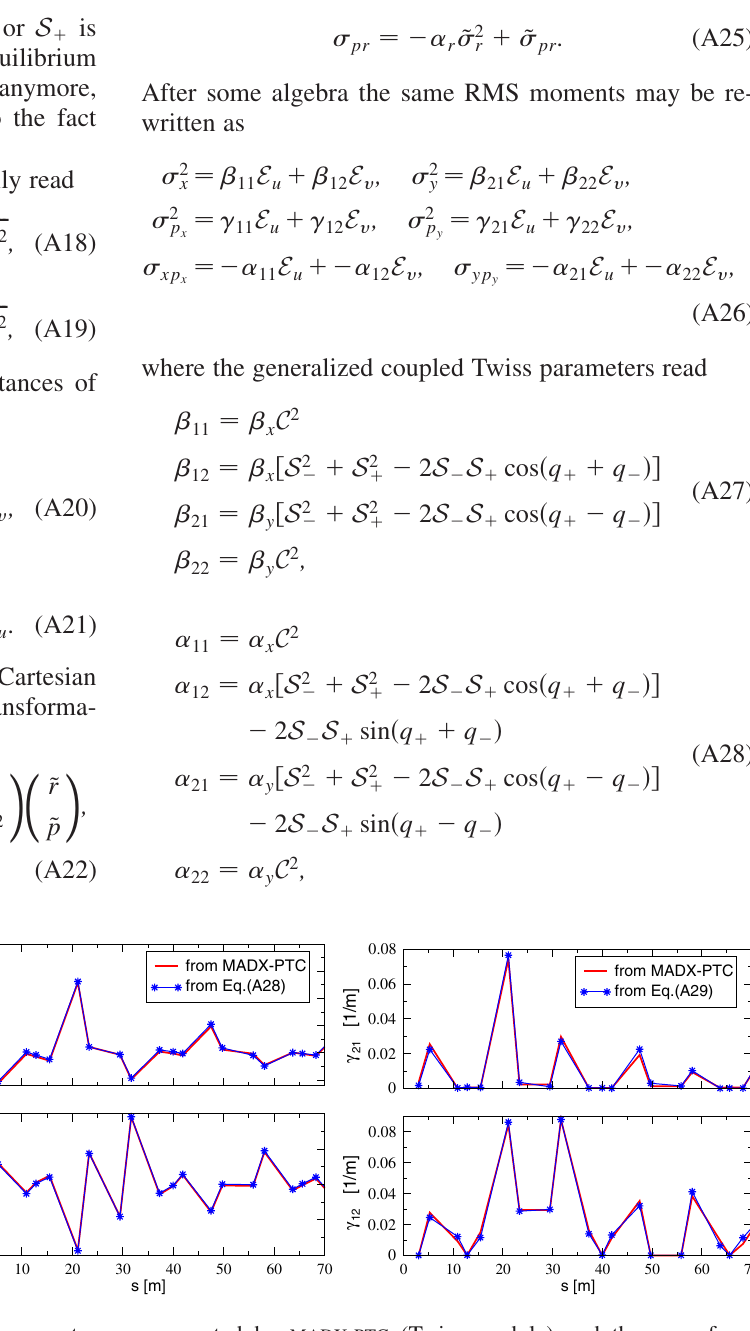
FIG. 11. Comparison between the coupled Twiss parameters as computed by MADX-PTC (Twiss module) and the ones from Eqs. (A27)–(A29) (zoom of the entire ring length of 844 m). Parameters refer to the ESRF storage ring lattice with the same coupling of Fig. 1. The uncoupled Twiss parameters, (cid:4) , (cid:7) , and (cid:8) , are obtained from the MADX by using the ideal uncoupled